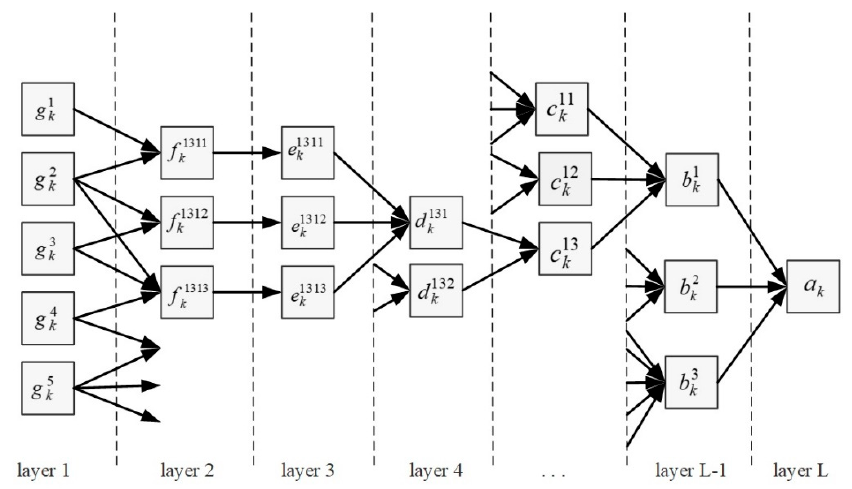
Figure 1. Functional network for calculation of the composite indicator for a k -th object.